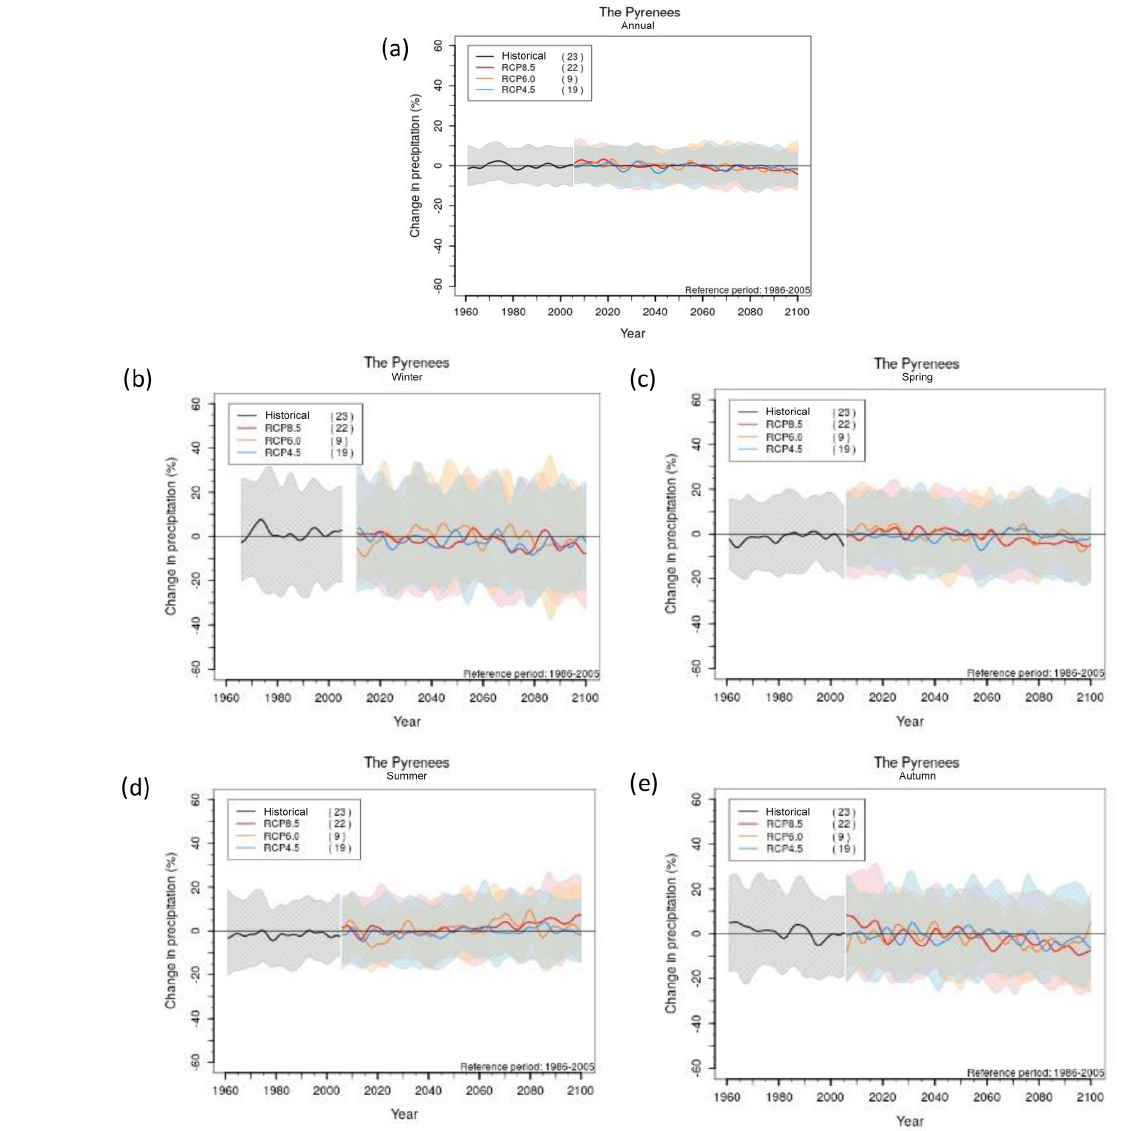
Figure 10. The same as Fig. 3 but for relative anomaly of accumulated precipitation (%). A 10-point Gaussian filter has been applied.